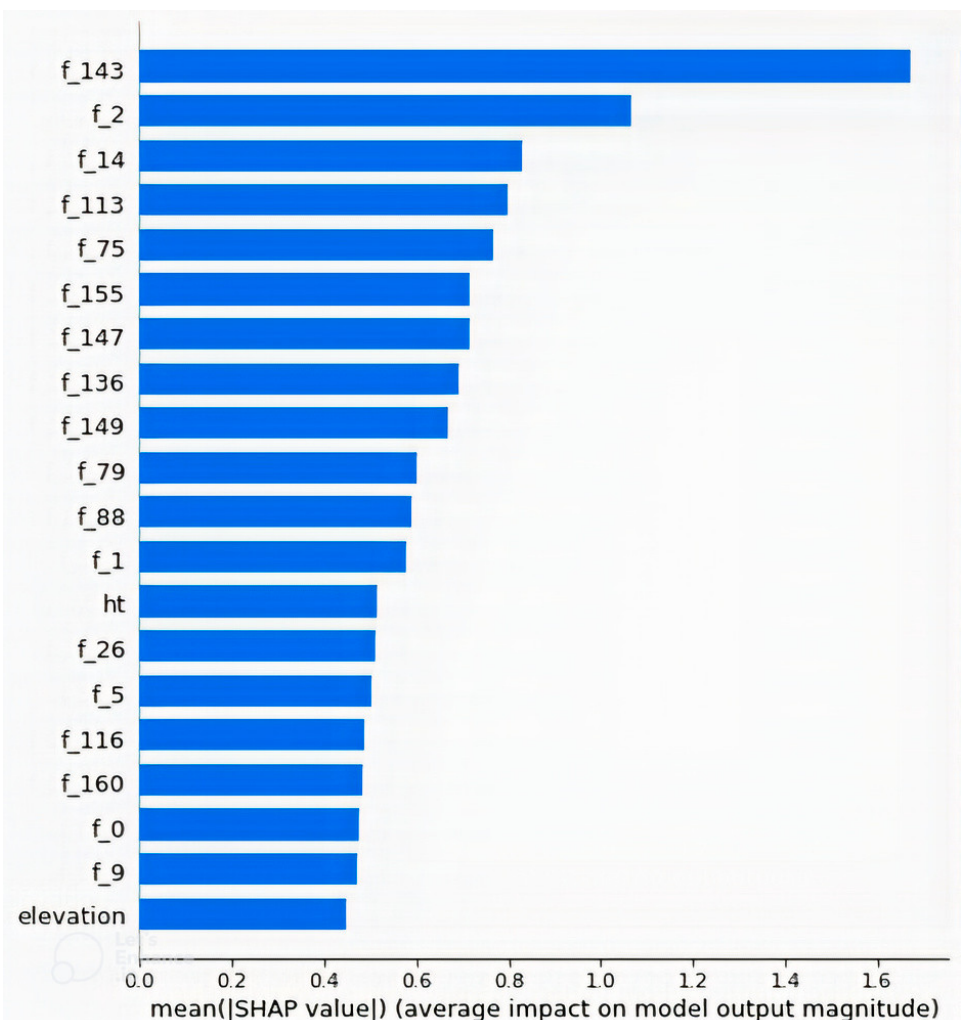
Figure 9. Mean feature importances of the top 20 features in the model with a combination of non-image features and CNN + GLCM features. “f_143”, which is a CNN-extracted feature, has the highest importance, while “elevation”, which stands for elevation at receiving antenna position, has the least importance among